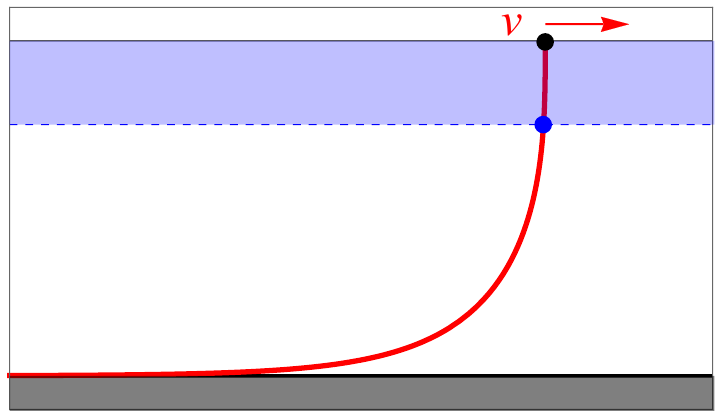
Figure 1 . The holographic dual of a heavy quark moving at speed v is a string (red curve) ending at the asymptotic boundary at the position of the quark (black dot). The strings extends from the asymptotic boundary at the top to the black brane horizon at the bottom of the (cid:12)gure. A cuto(cid:11) (dashed blue line) is introduced and the shaded region between the boundary and the cuto(cid:11) is \integrated out". One is left with the string in the region between the cuto(cid:11) and the horizon and determined boundary conditions for the endpoint of the string at the cuto(cid:11) (blue